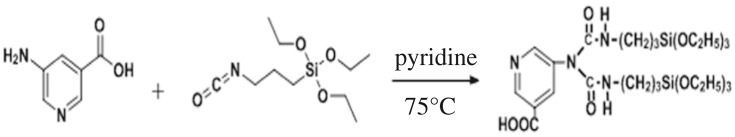
The synthesis route of ANA-Si.